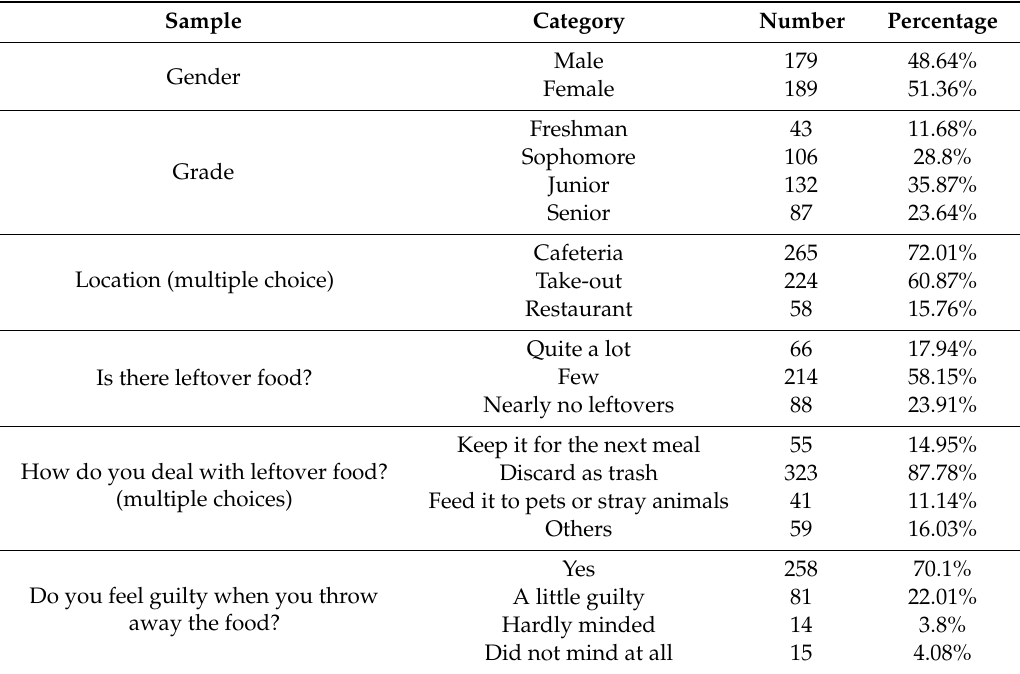
Table 2. Table showing basic sample